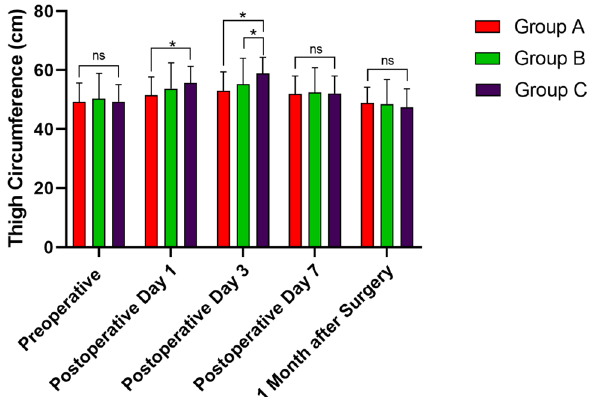
Figure 2. Differences of pre-. and postoperative thigh circumferences (cm) among groups. *represents the difference between these two groups was statistically significant ( P < 0.05); ns, represents no significant inter- group difference was observed.